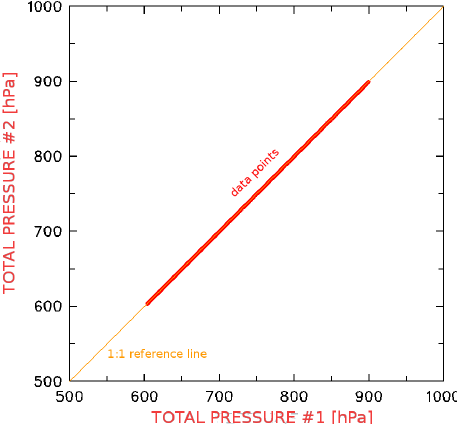
Figure 3. Measurements made at 1Hz during the 17 Novem- ber 2011 flight of the C-130. All measurements are included for times when the true airspeed exceeded 50ms − 1 (to exclude a short period with flaps deployed at the end of the flight). The measure- ments plotted are the total pressure p t , measured by two indepen- dent systems using two different pitot tubes and sets of static but- tons. The root-mean-square deviation from this line is 0.1hPa, and the similar deviation from a best-fit line is less than